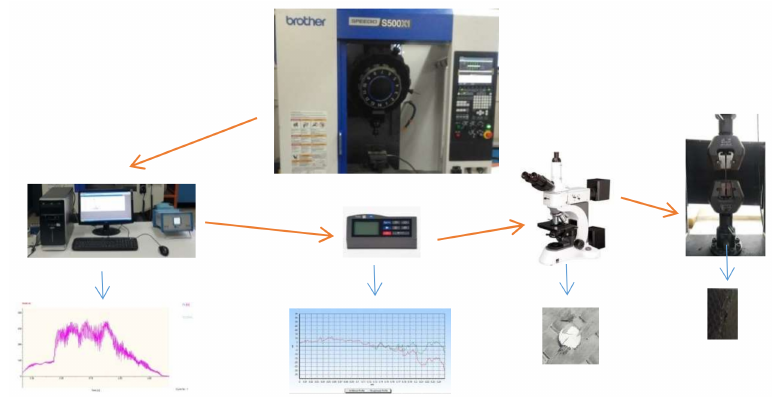
Figure 1. Flow chart of experimental setup.